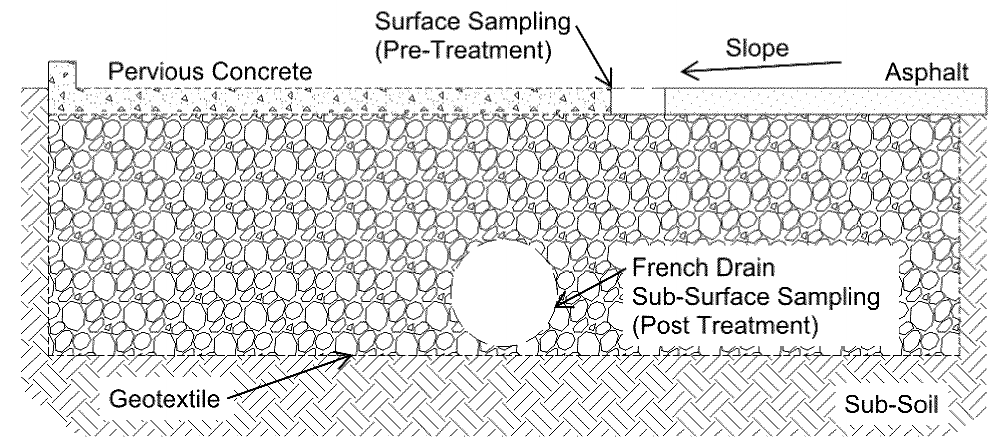
Figure 2. Schematic cross section of the Alcoa pervious pavement site.